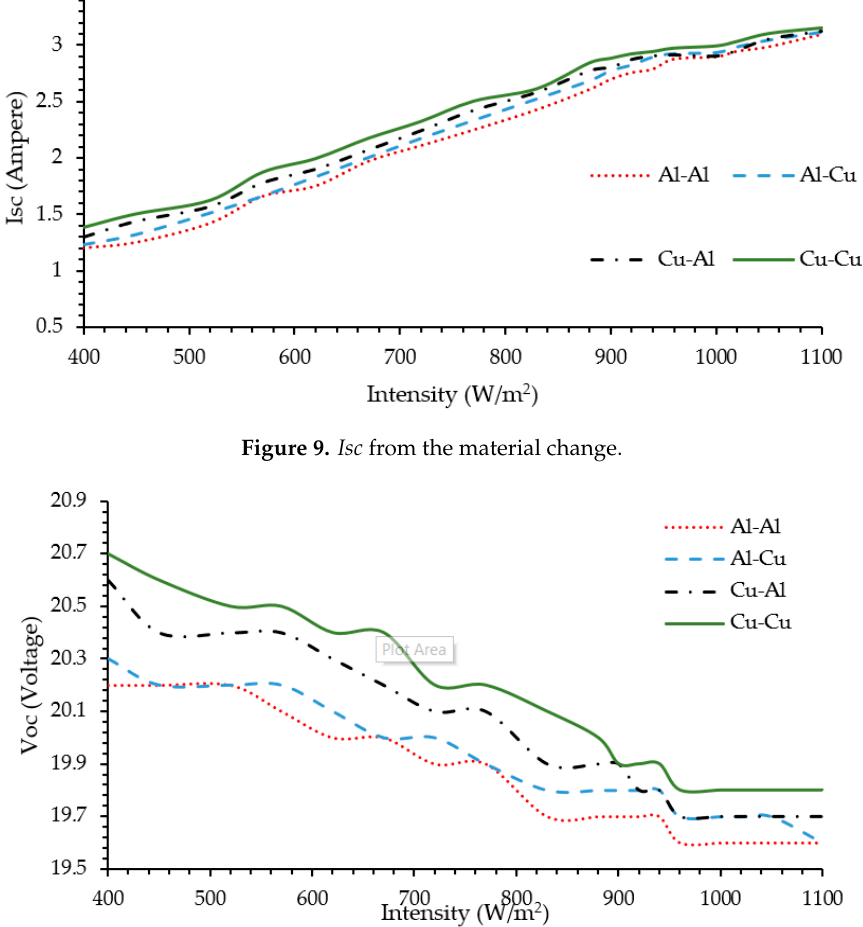
Figure 10. V OC from the material change.